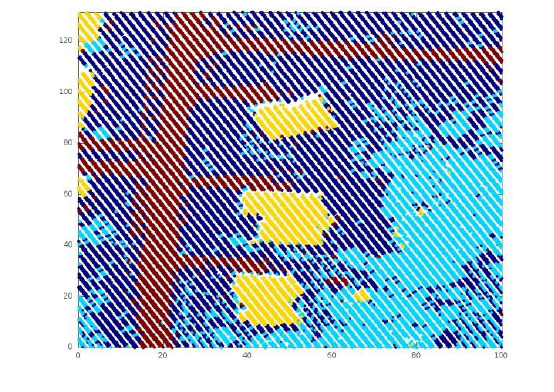
Figure 7: Fitting and